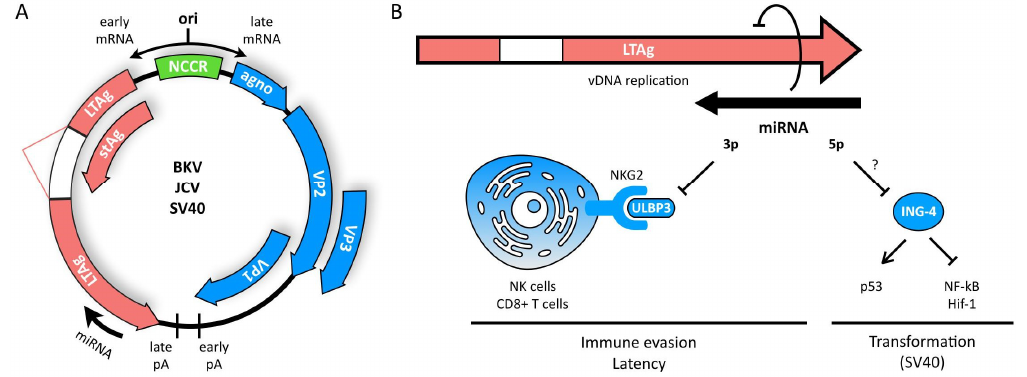
Figure 1. Betapolyomaviruses encode a miRNA in the LTAg region of the genome. ( A ) Genomic organization of the beta polyomaviruses BKV, JCV and SV40. The genome is divided into an early and late region encoded on opposite strands and separated by a non-coding control region (NCCR). The late strand of the genome encodes three capsid proteins (VP1-3) and two mature miRNAs originating from the same pre-miRNA located at the 3′ end and antisense to the large tumor antigen (LTAg) gene. The polyadenylation sites (pA) are involved in the early-to-late switch. ( B ) Perfect complementarity of the miRNA to the early viral LTAg mRNA results in direct cleavage and inhibition of LTAg expression to promote latency. The 3p arm of the miRNA directly downregulates expression of the stress-induced ligand ULBP3, contributing to immune evasion. The SV40-encoded miRNA 5p arm mimics hsa-miR-423 and is therefore suggested to contribute to cell transformation by downregulating the tumor suppressor ING-4.